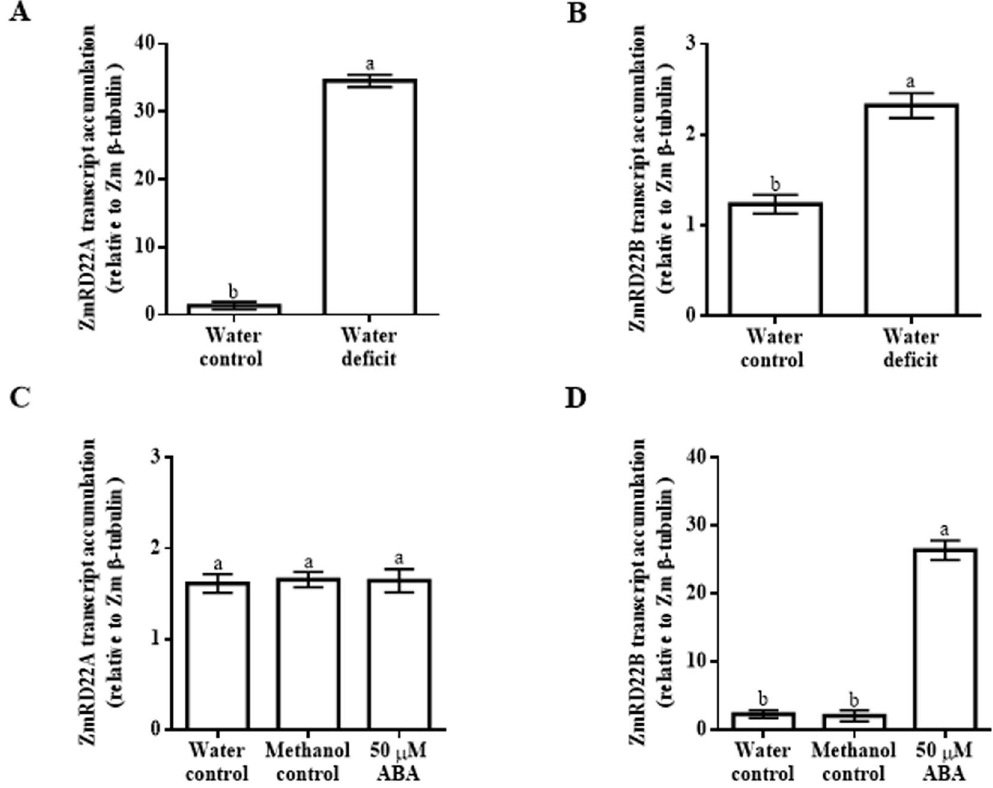
Figure 4. Quantitative RT-PCR analysis of ZmRD22A and ZmRD22B expression in response to exogenous ABA in maize leaves. ( A ) ZmRD22A transcript accumulation relative to maize β -tubulin in the 2 nd youngest leaves of maize seedlings treated with 50 µ M ABA. ( B ) Representation of ZmRD22B transcript accumulation in the 2 nd youngest leaves, calculated in relation to Zm β -tubulin, in response to exogenous treatment of maize seedlings with 50 µ M ABA. In all the graphs, the water control is indicated by the first bar, the methanol control by the second bar and the ABA treatment by the third bar. Bars are means of three independent experiments and expression levels are signified as arbitrary values. The error bars signify standard deviation, bars with the same letters are statistically similar where p <